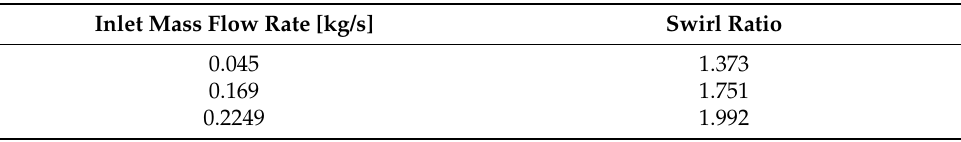
Table 3. Swirl ratio as a function of the inlet flow